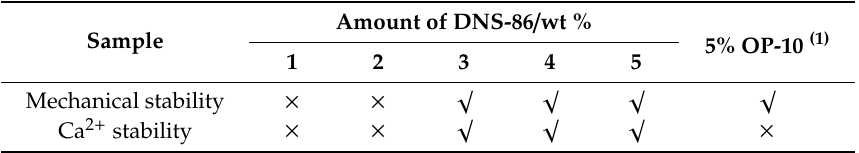
Table 2. E ff ect of the DNS-86 amount on stability of